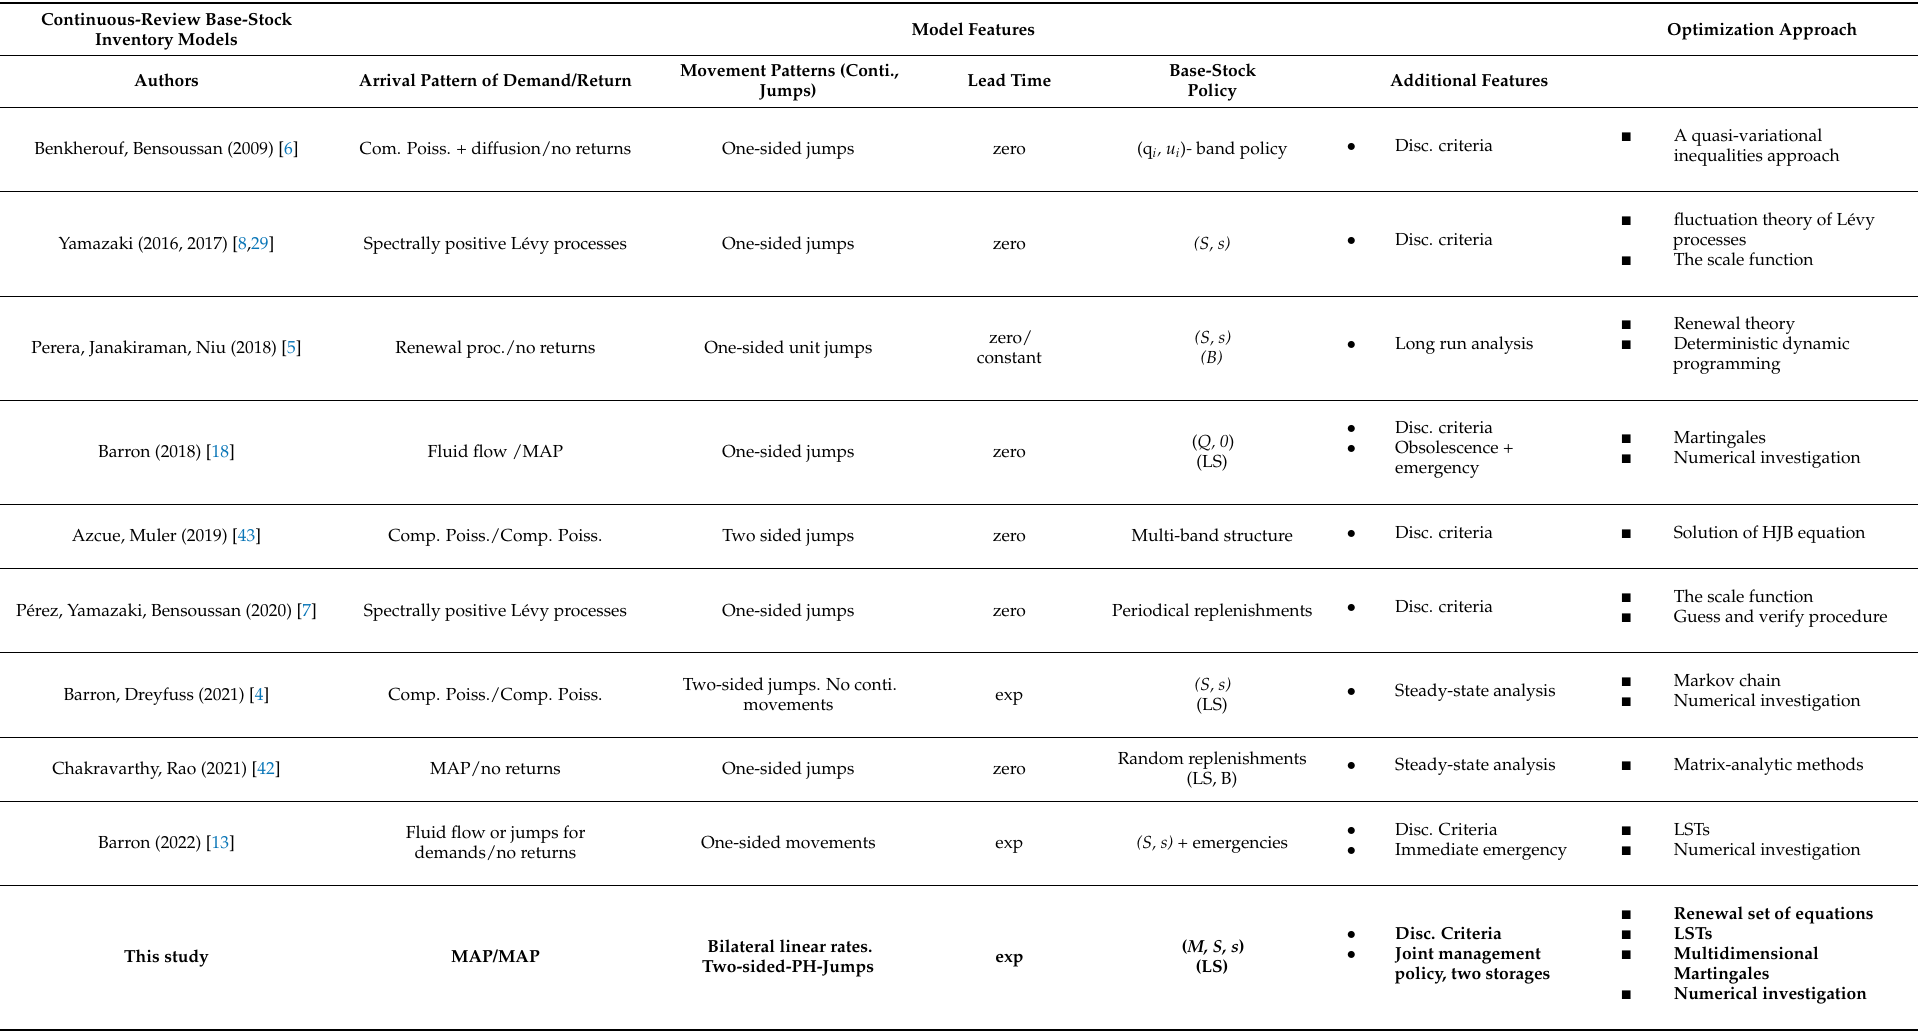
Table A1. Selected studies on continuous review base stock inventory